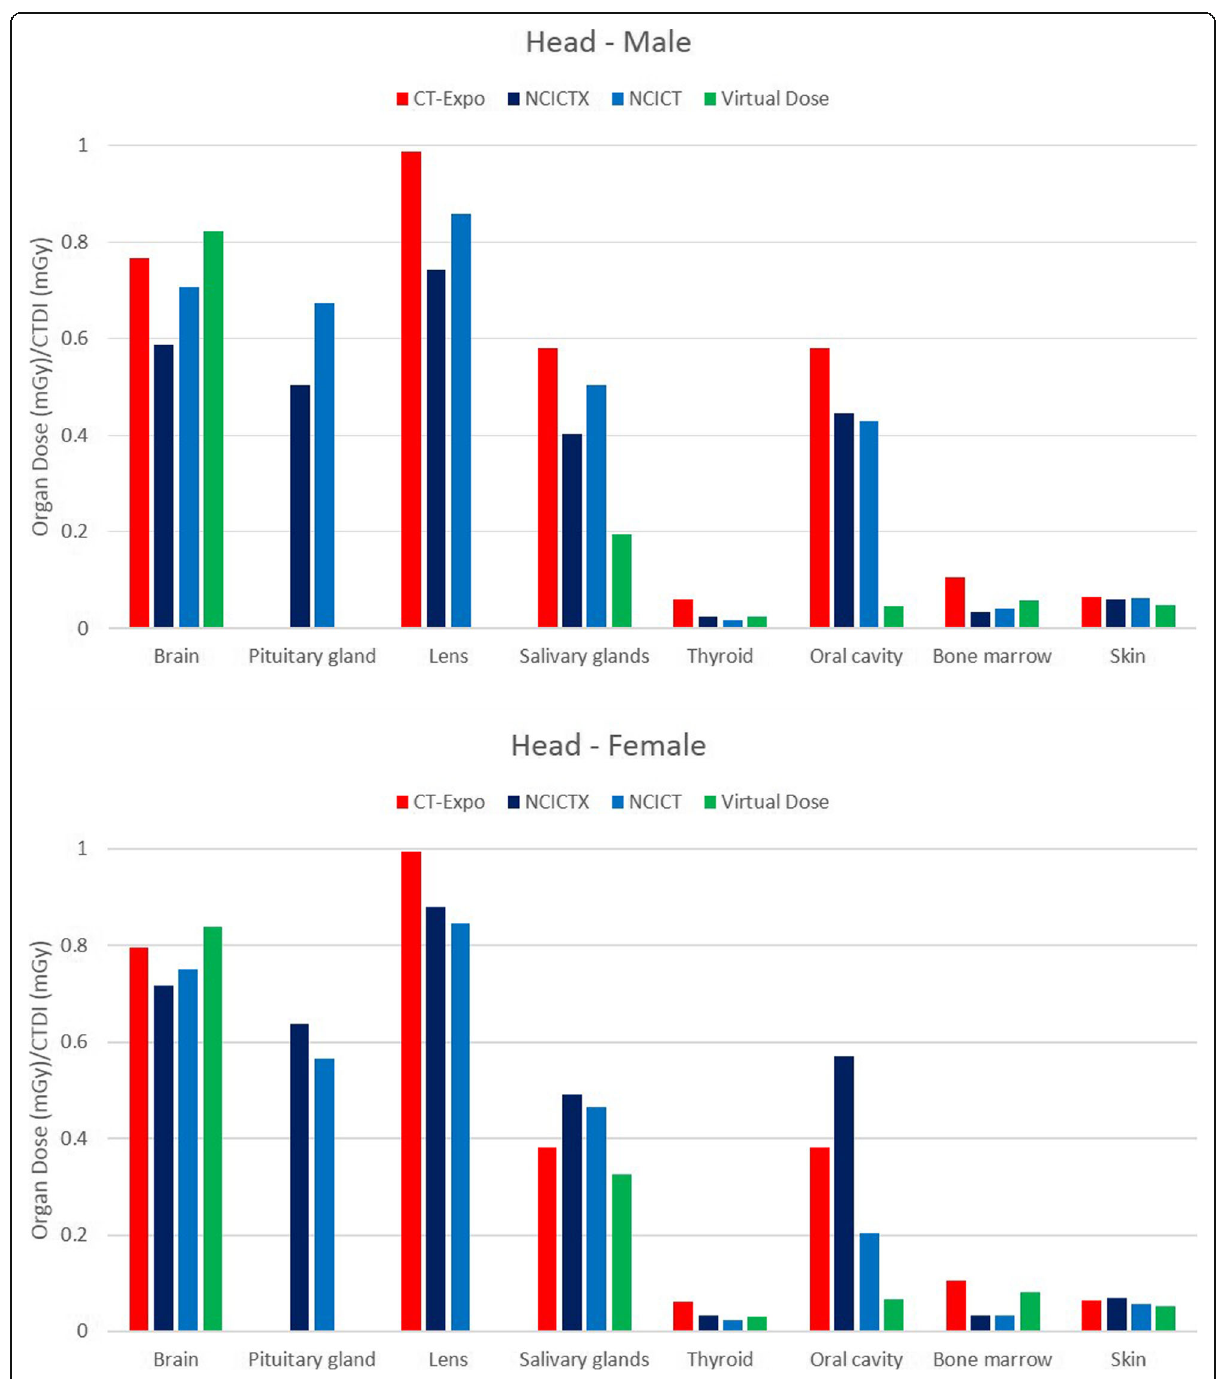
Fig. 2 Organ dose per volume computed tomography dose index (CTDI vol ) unit, obtained simulating the CT Head protocol with CT-Expo, NCICTX, NCICT, and Virtual Dose, using a male and a female phantom. These values are dose coefficients, obtained as organ dose (mGy) and CTDI vol (mGy) ratio. Brain, pituitary gland, and lens are completely irradiated. Only NCICTX and NCICT consider the pituitary gland. Virtual Dose does not consider